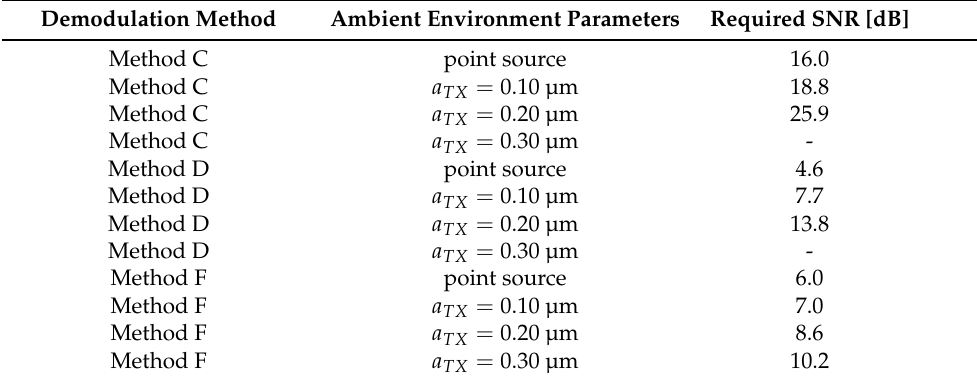
Figure 15. BER characteristics with respect to the volume of the transmitting molecule. Table 6. Effect of the volume of transmitting molecule on Required